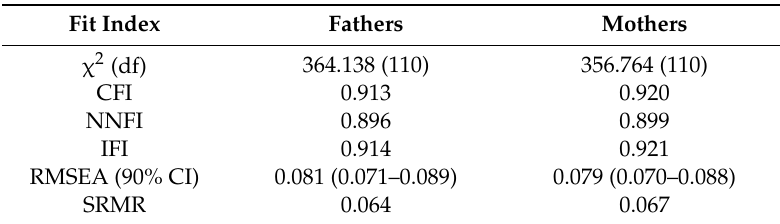
Table 3. Model fit for fathers’ and mothers’ parenting